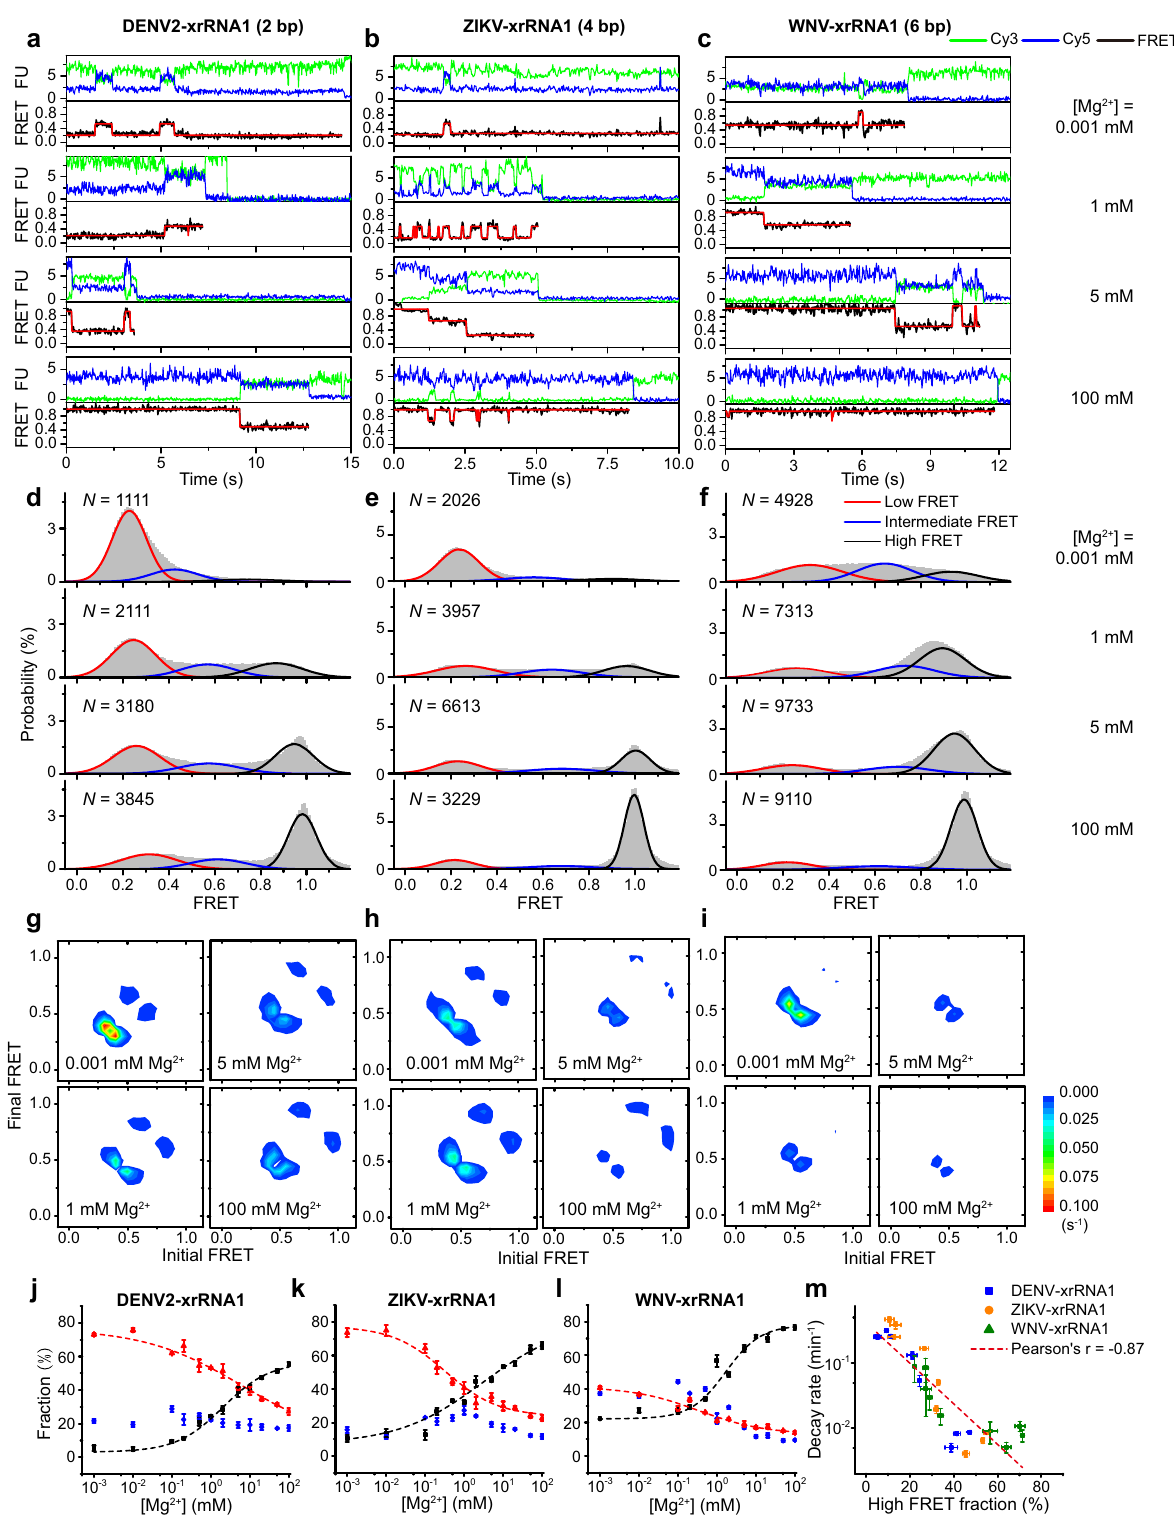
barrier of H state → I state to decrease transition rate of H state → I state , whereas the moderately decreased energy barrier of I state → H state causing increased transition rate of I state → H state , can only be accounted as the minor stabilizing factor of high Mg 2 + . The PK2 length strongly affects the stability of H state across the xrRNAs, especially at the low Mg 2 + . Besides, the